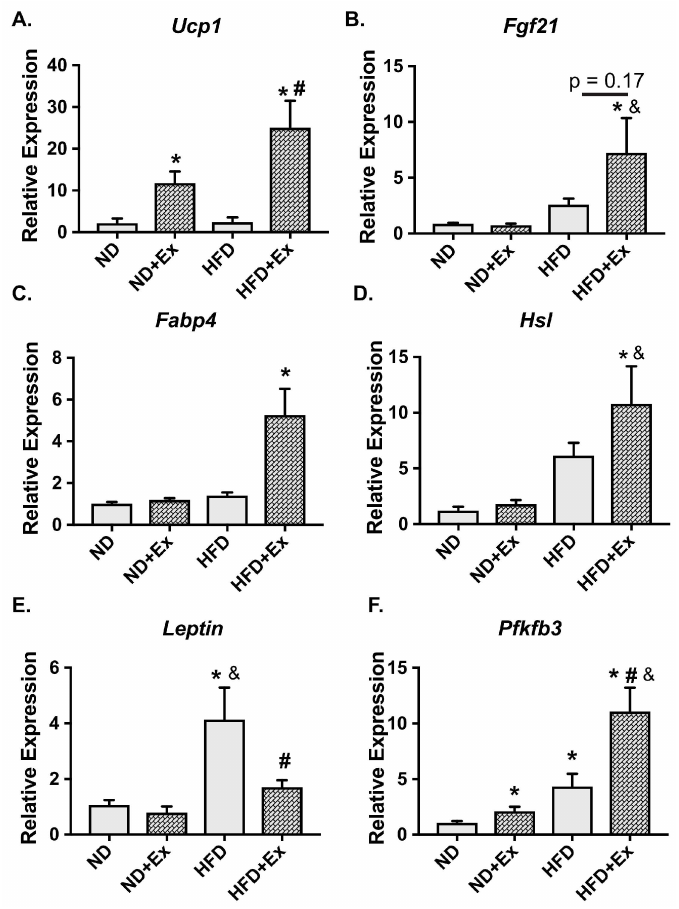
Figure 2. Metabolic gene expression in scWAT is improved with exercise. ( A – F ): scWAT was harvested and mRNA expression was measured using qPCR (* p < 0.05 vs. ND; # p < 0.05 vs. HFD; & p < 0.05 vs. ND + Ex; N = 5–7 mice /